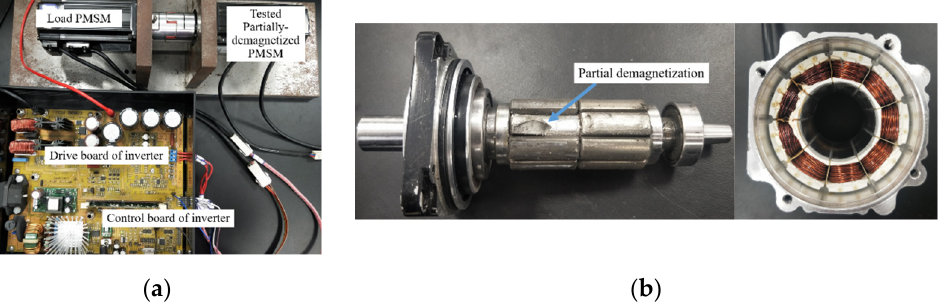
Figure 4. Partially demagnetized PMSM and experimental setup. ( a ) Experimental setup; ( b ) rotor and stator of partially demagnetized PMSM.